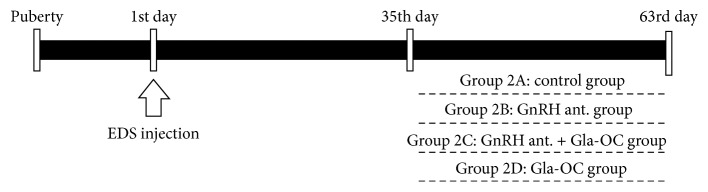
Post-EDS regeneration of the adult Leydig cell surgical procedure.